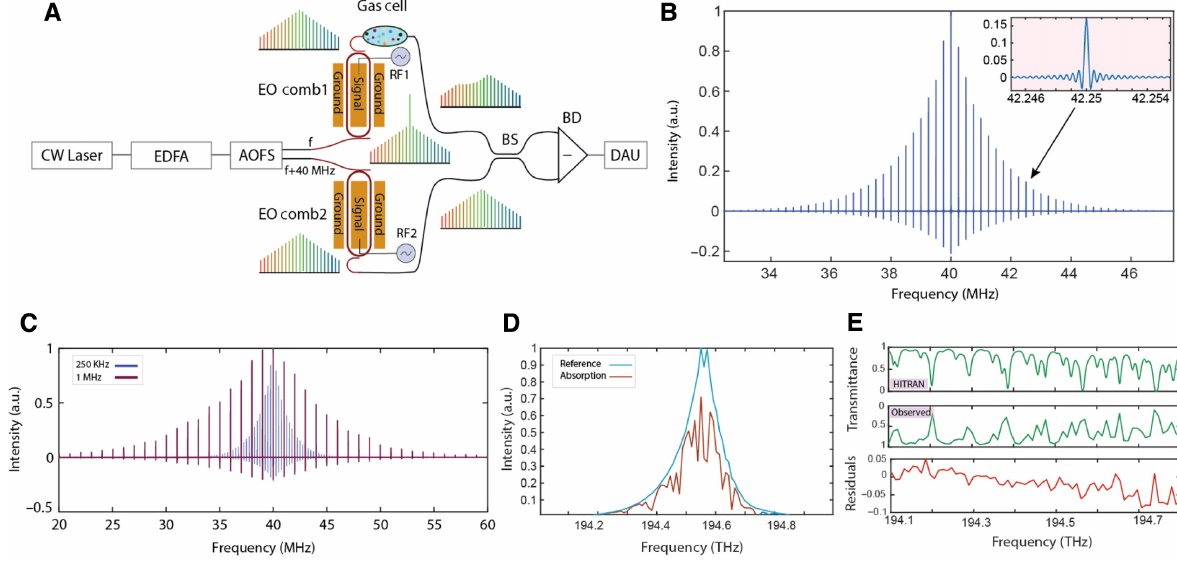
Figure 27: Dual-comb spectroscopy. (A) Schematic of dual-comb spectroscopy with integrated LN electro-optic frequency combs. (B) Measured spectrum of dual comb (measurement time 195 s). (C) Transmission spectra of the dual comb with difference in microwave modulation frequencies equal 0.25 and 1 MHz, demonstrating the reconfigurable refresh rate. (D) Absorption spectra of acetylene. (E) Comparison of measured transmission spectrum with HITRAN database and the corresponding residuals. Copyright from